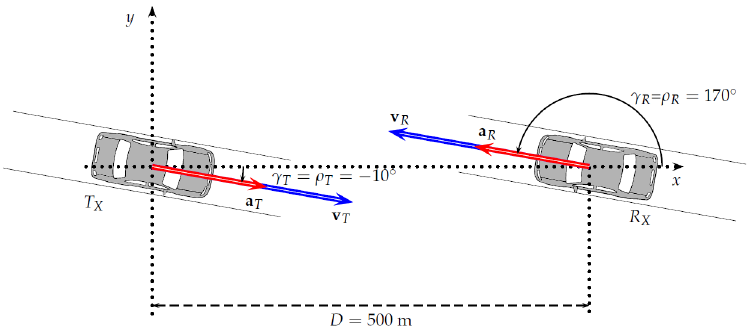
Figure 7. Scenario III: Propagation scenario resembling a highway situation, where two vehicles are approaching on opposite